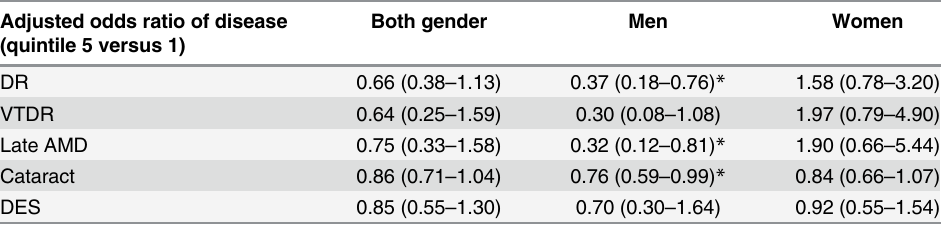
Table 6. Relative association between serum 25-hydroxyvitamin D and ocular diseases including dia- betic retinopathy (DR), vision threatening diabetic retinopathy (VTDR), age-related macular degenera- tion (AMD), cataract and dry eye syndrome (DES) among representative Korean adults. Adjusted odds ratio of disease (quintile 5 versus